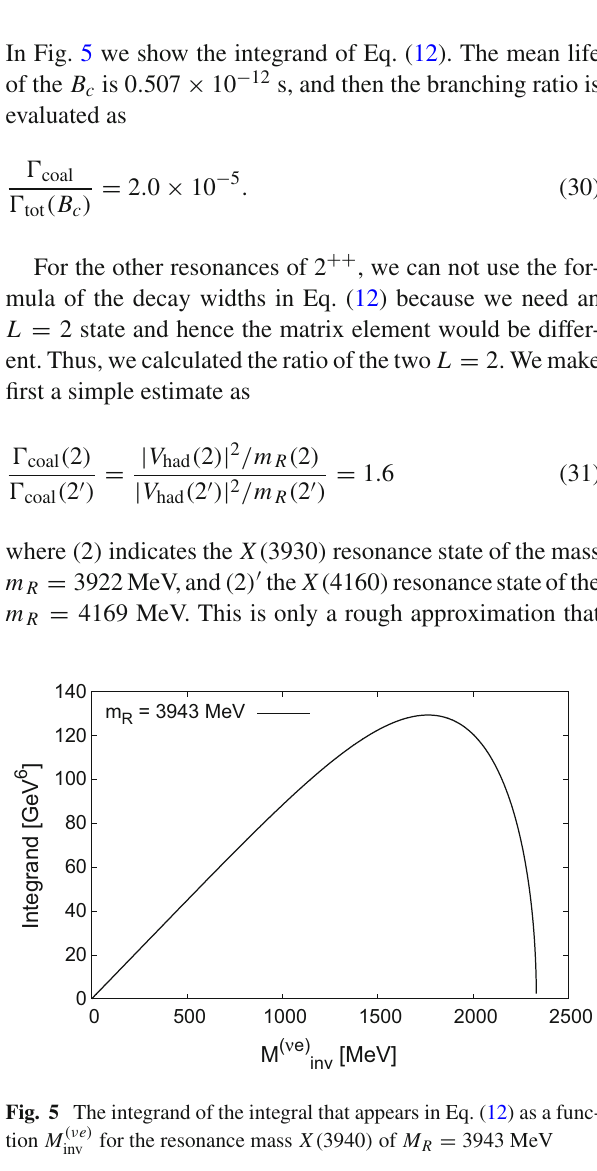
does not take into account the different masses and phase space, nor the L = 2 character of the